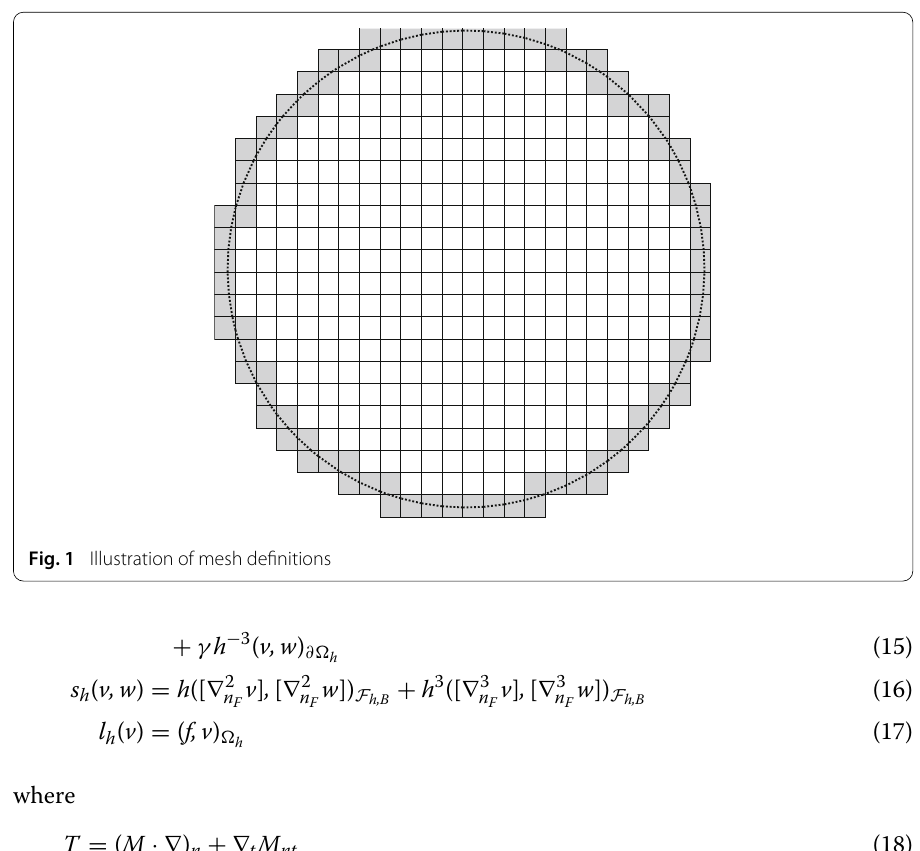
Fig. 1 Illustration of mesh